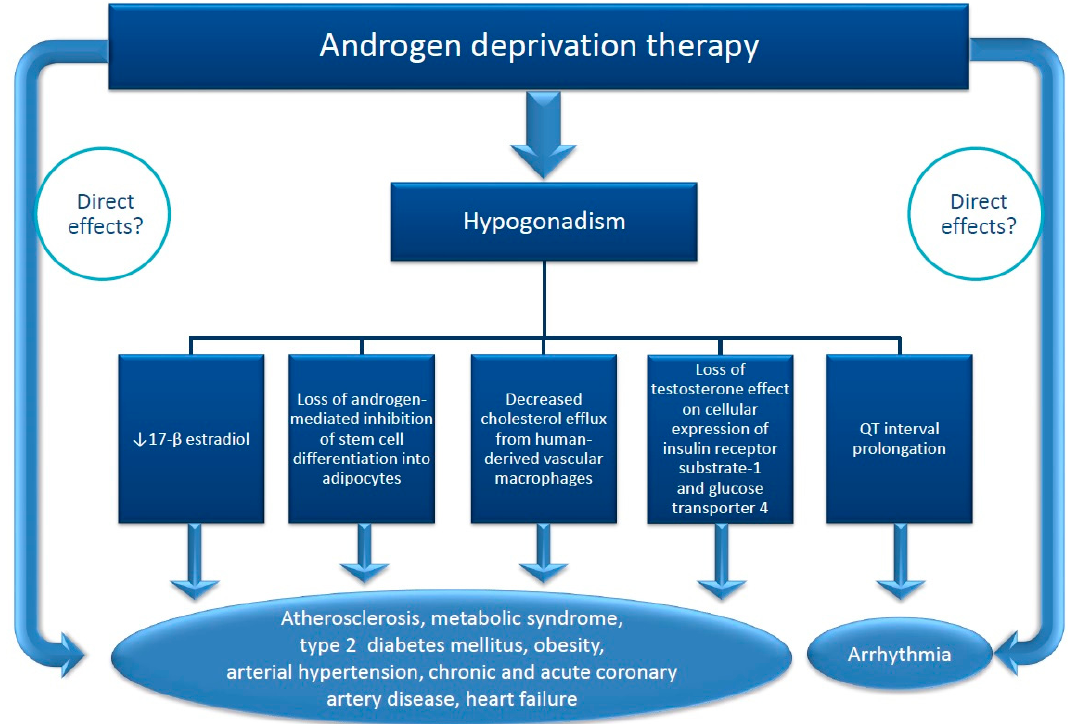
Figure 3. Supposed mechanisms of cardiovascular toxicity of androgen deprivation therapy (ADT) in patients with prostate cancer. Hypogonadism induced by ADT is involved in the occurrence of the cardiotoxicity by many mechanisms. The direct contribution of ADT is not obvious excepting CYP 17 inhibitors which indirectly induce a surge of mineralocorticosteroid secretion and GnRH agonists.